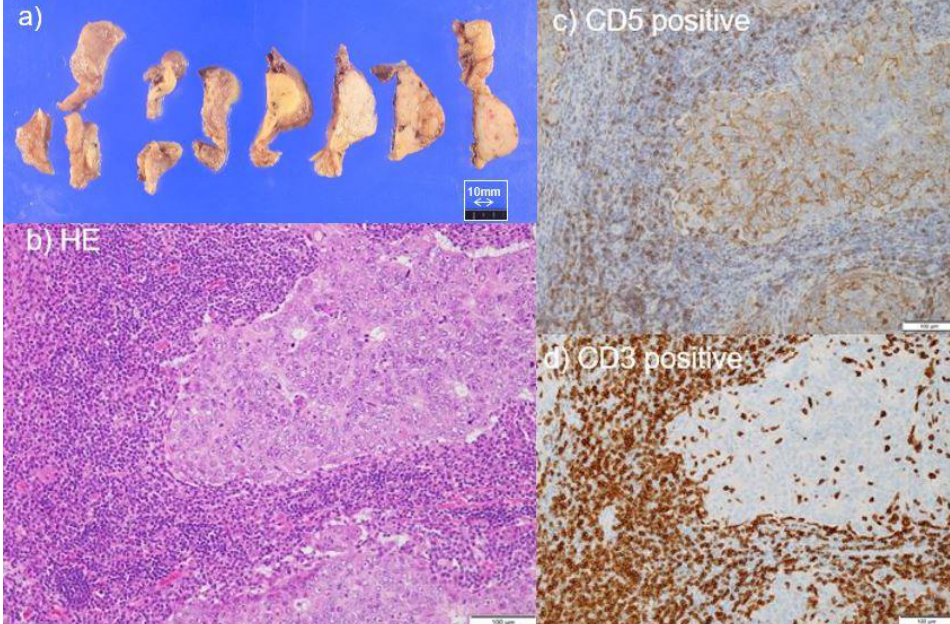
Figure 1. ( a ) Macroscopic appearance was yellowish-white necrotic areas. ( b ) The tumor cells were enlarged with large edematous nuclei and significant infiltration of lymphocytes in hematoxylin eosin staining. Immunostaining showed that the tumor cells were ( c ) CD5-positive and ( d ) the lymphocytes were